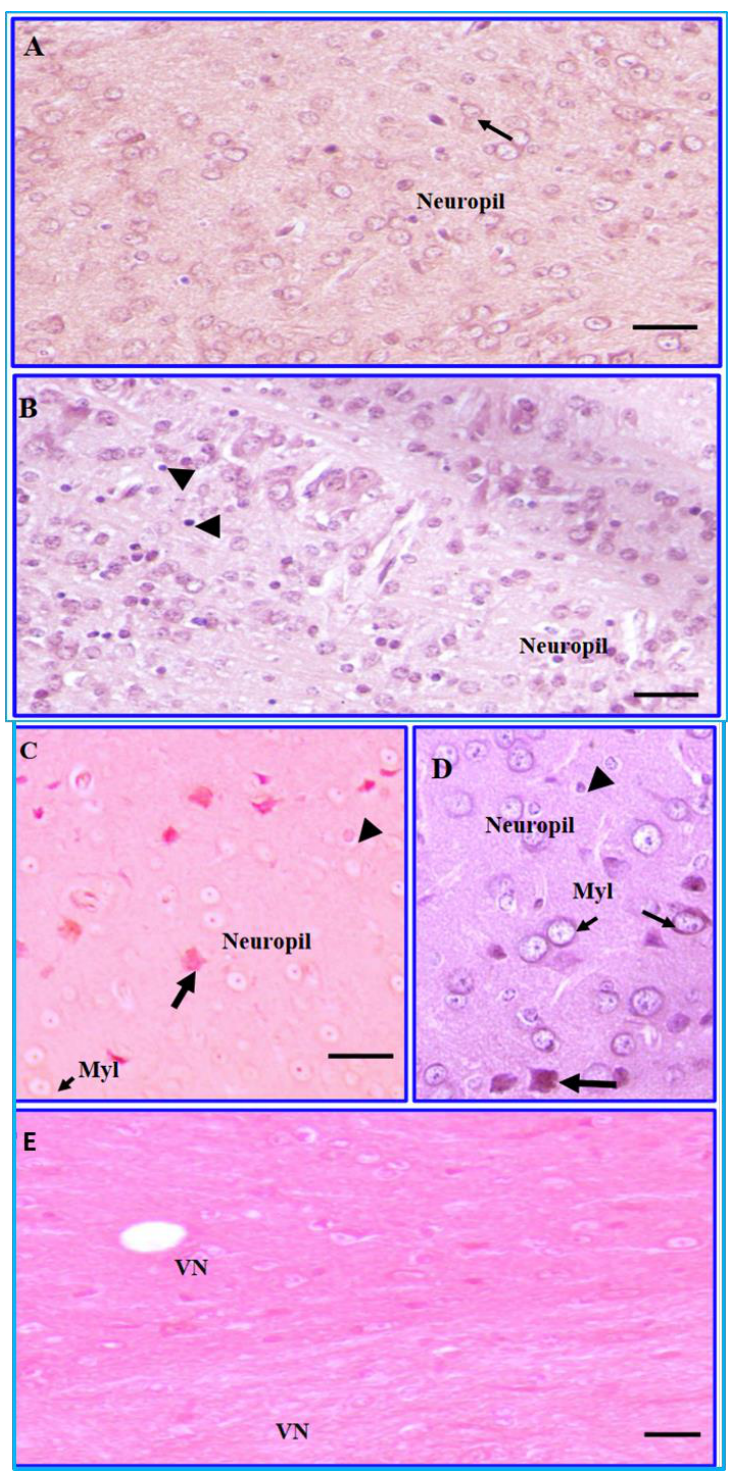
Figure 4. Histopathological alterations in cerebral hemispheres of brain of newborn pups (normal, ( A ) and Diabetic ( B )) and 5‑week‑old offspring (normal, ( C , D ) and Diabetic ( E )). Normal histological appearance is shown with normal neuropil and lightly stained nuclei. ( C , D ). Section at the cere‑ bral hemisphere of the brain of 5‑week‑old mice born for normal mothers. Darkly stained nuclei (apoptotic, arrows) and slightly vacuolated neuropil are shown. Slightly vacuolated Neuropil (VN), myelinated nerve cells (Myl). n = 4–5, magnification bar equals 10